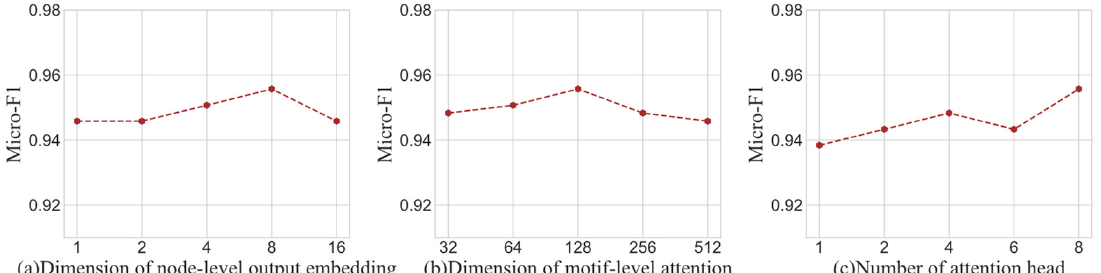
Figure 5. MBHAN parameter sensitivity analysis.